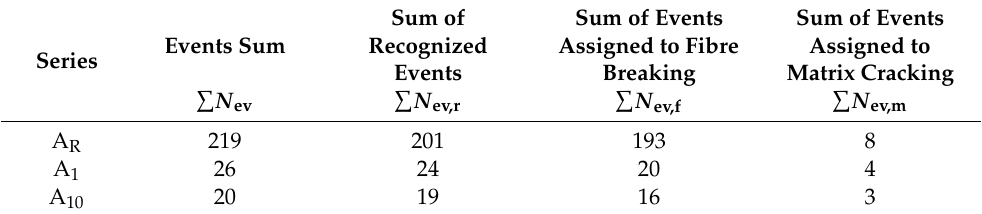
Table 4. Events recognized as respectively accompanying fibre breaking and cement matrix cracking for fibre-cement boards of series A R –A 10 .